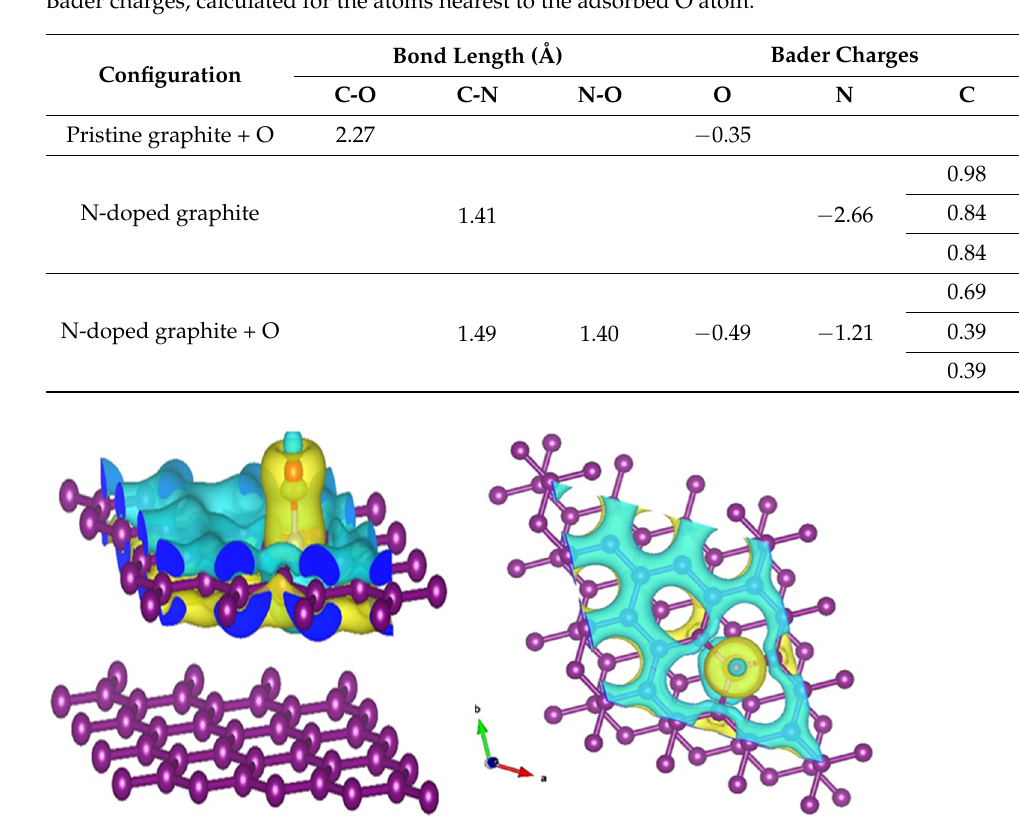
Figure 10. The charge density difference calculated for the N-doped graphitic surface with O adsorption. The pristine and N-doped graphite surfaces are also shown. The yellow and blue isosurfaces indicate charge gain and charge depletion, respectively. The isosurface level is 0.062368 e/Å3”. The color code of the atoms is as follows—purple: C, red: O, white: N.